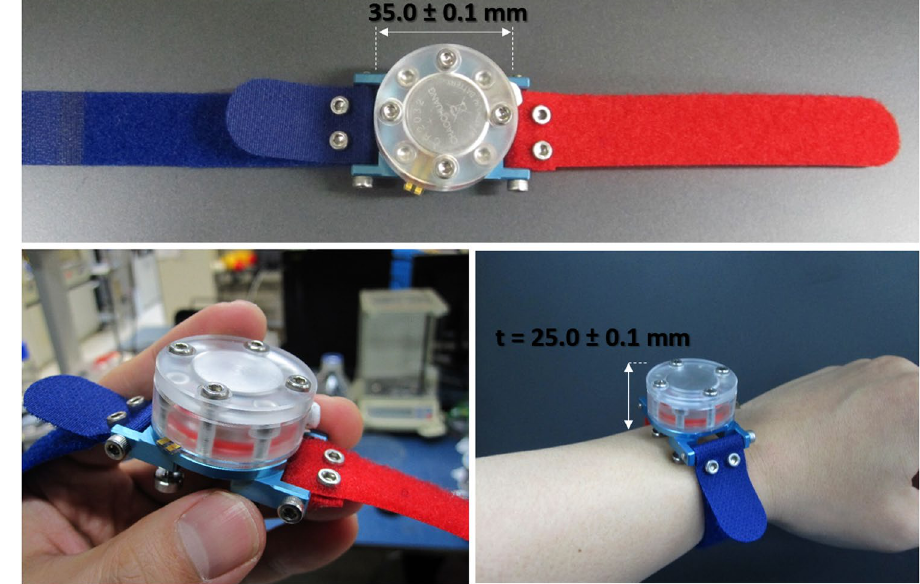
Figure 3. The fabricated watch-type sweat rate